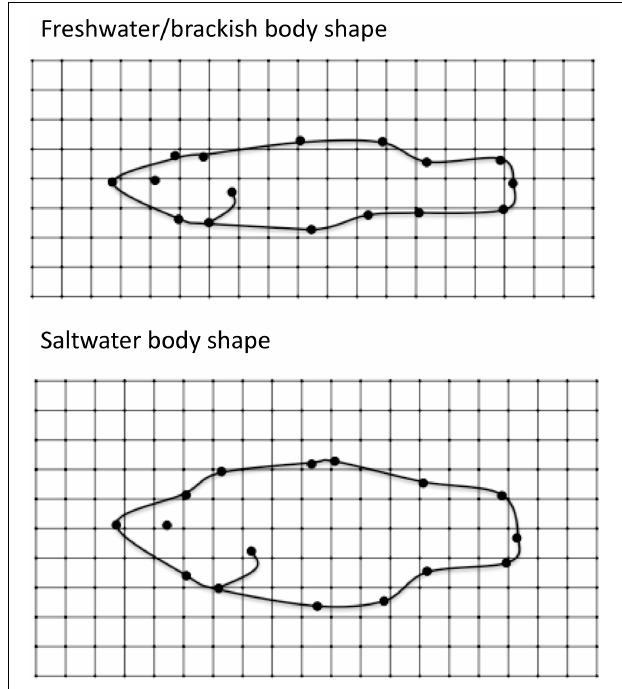
FIGURE 5 | Optimal body shape as predicted by the adaptive bivariate OU predictor analysis. See Supplementary Material for a detailed description of OU predictor analysis. (Top) Optimal body shape of “freshwater” fish. (Bottom) Optimal body shape of saltwater